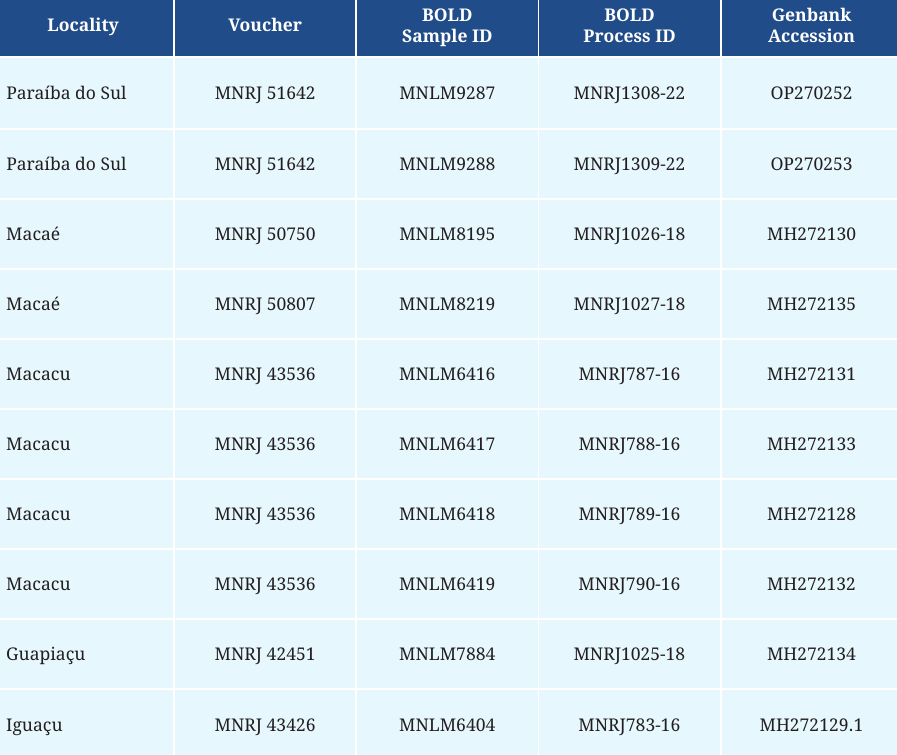
TABLE 1 | BOLD Process ID and GeneBank Accession codes for samples of Rineloricaria nudipectoris used to obtain molecular data in this study. Sample ID refers to the DNA Extract Collection of the Laboratório de Pesquisa em Biodiversidade Molecular, Museu Nacional (MNLM) which are also used to record specimen data in BoldSystems (http://www.boldsystems.org/). Voucher code refers to the whole- organism catalog numbers, and Specimen/Tissue code refers to tissue catalog number in the Fish Tissue